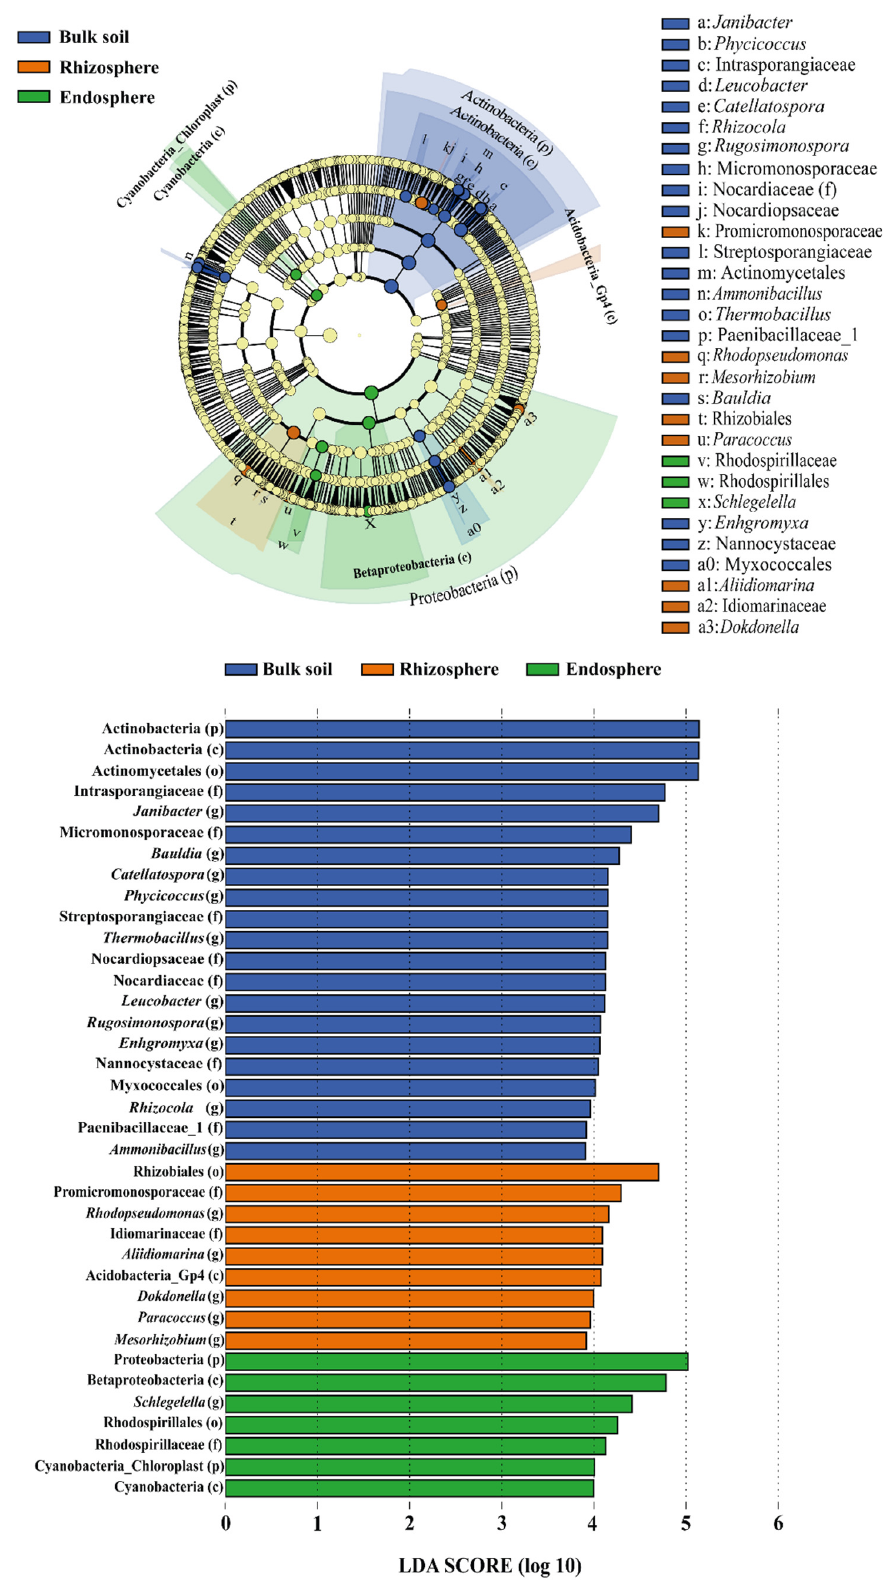
Figure 3. Linear discriminant analysis Effect Size (LEfSe) used to evaluate the significantly enriched OTUs in the bacteriomes of bulk soil (blue), rhizosphere (orange) and endosphere (green) associated with Tropaeolum majus. The analysis was performed in the Huttenhower Lab online platform with the Galaxy Community Hub server.